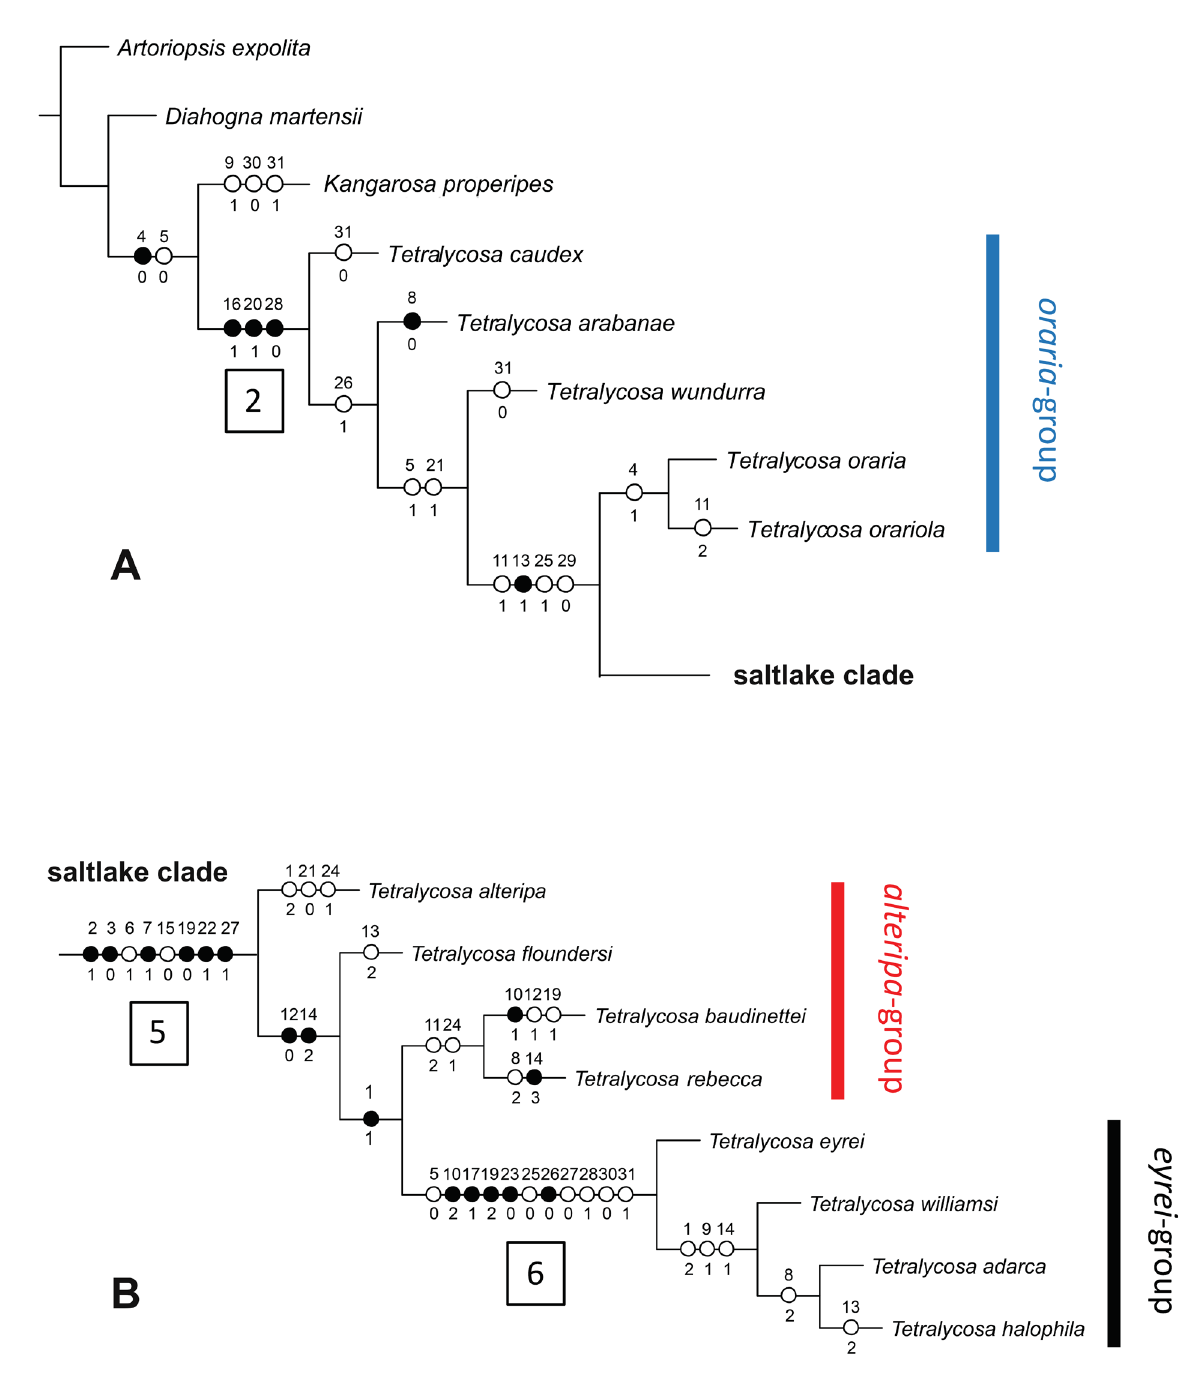
Fig. 4. Phylogenetic hypothesis of Tetralycosa Roewer, 1960 based on 31 morphological and one ecological characters. A . Basal branches including outgroups. B . Terminal salt lake clade (L = 71, Ci = 61, Ri = 80). Bremer support values > 1 are indicated by numbers in squares below the